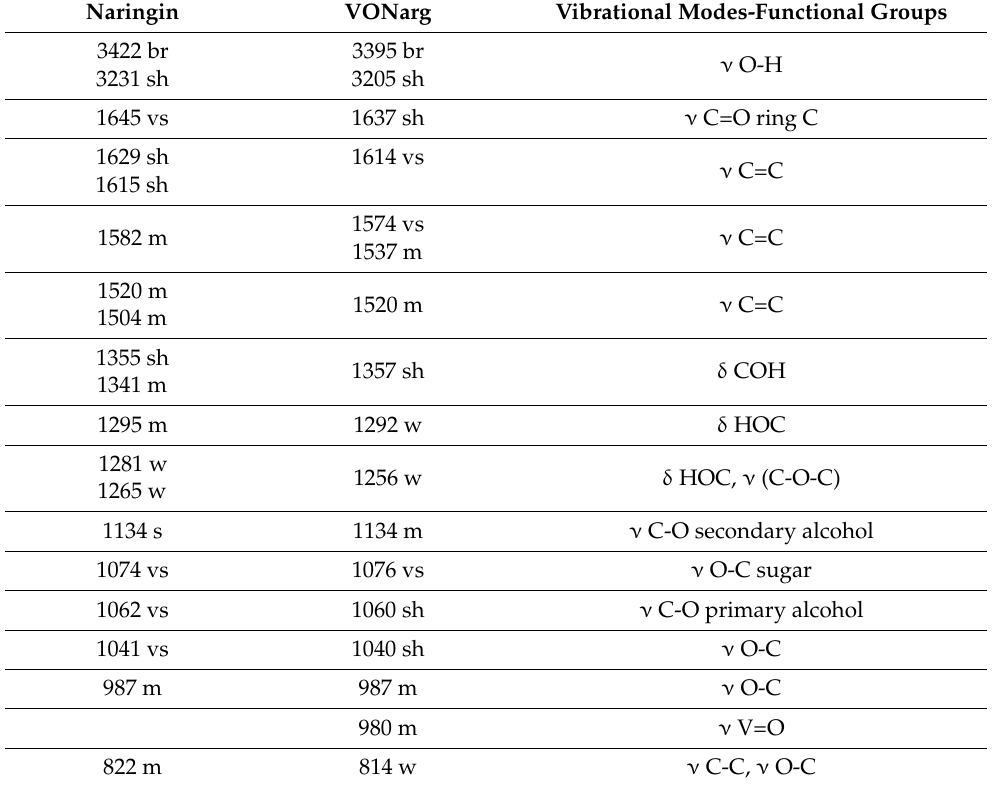
Table 1. Assignment of the FTIR spectra of naringin and the oxidovanadium(IV) complex (band positions in cm − 1 ) a . Naringin VONarg Vibrational Modes-Functional Groups 3422